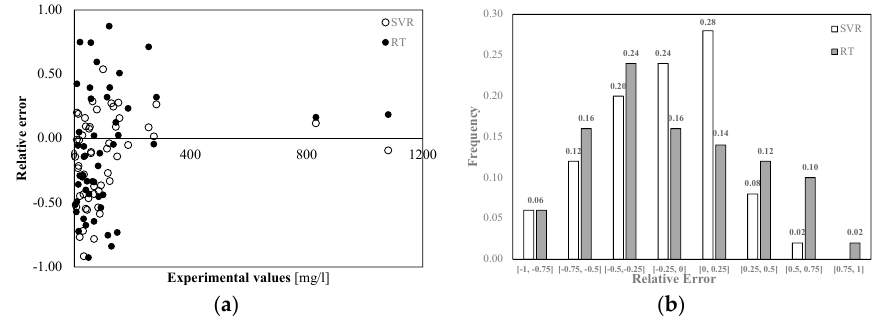
Figure 5. Distribution of errors in the TSS predictions. ( a ) Relative error versus experimental values; ( b ) Frequency distribution.